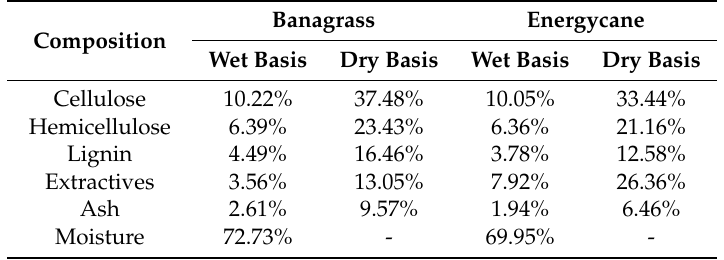
Table 1. The composition of banagrass and energycane on a wet and dry basis.